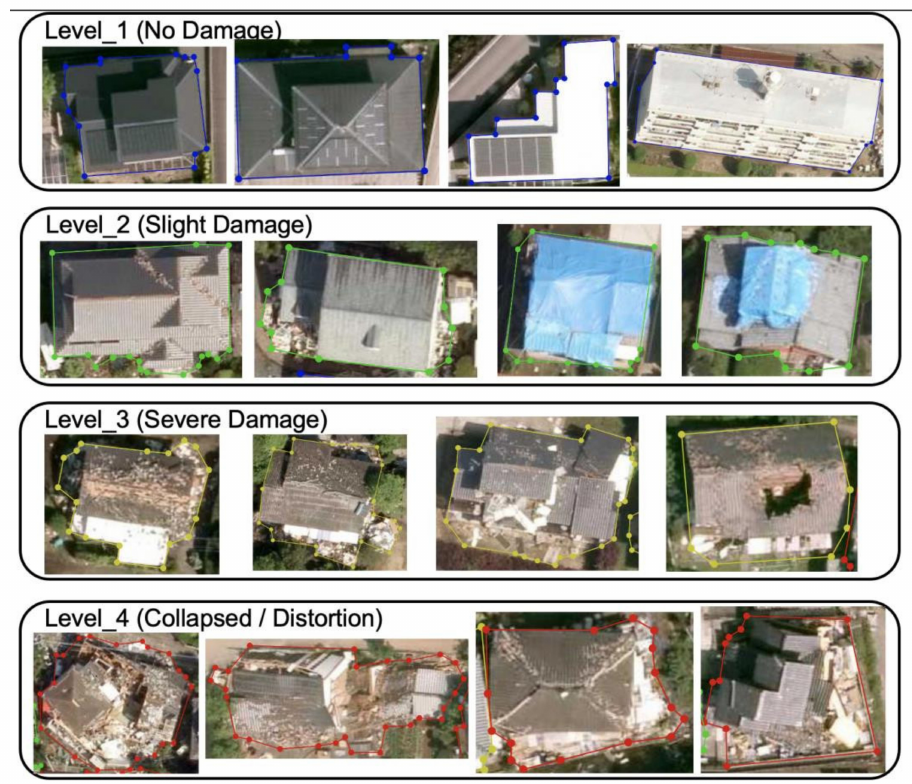
Figure 4. Label examples of the buildings in levels 1 to